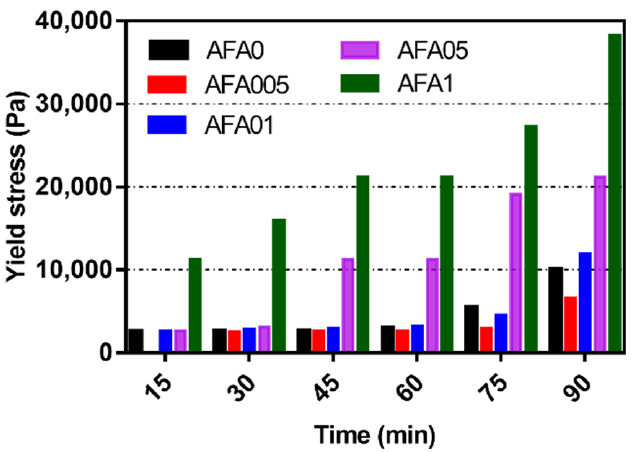
Figure 5. Influence of AFA dosage on the yield stress of 3DPC.